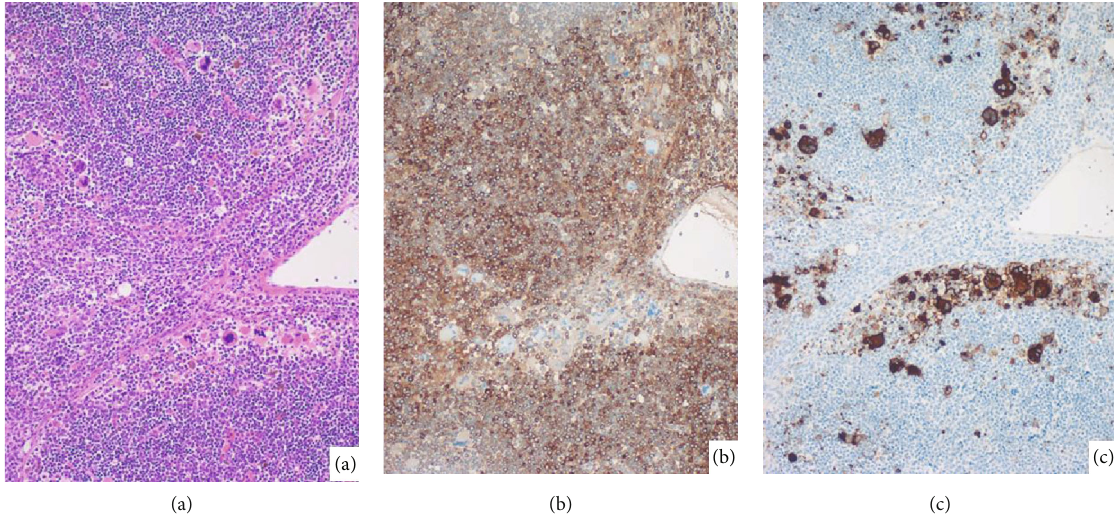
Figure 4: Lymph node histology ((a) H&E, (b) MPO, and (c) CD61). The nodal parenchyma is di ff usely in fi ltrated by MPO-positive leukemic blasts. CD61-positive megakaryocytic di ff erentiation is observed mainly in the sinus. The small-sized blasts lack expression of